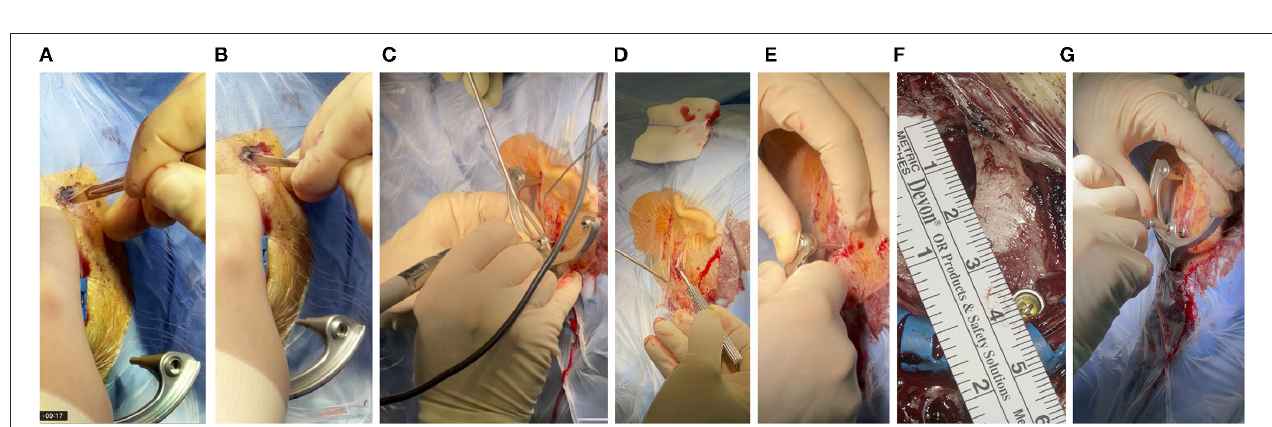
FIGURE 3 | (A) With a thin scalpel, the skin is punctured through the foil at the three marked spots for the pins of the frame, resulting in incision lengths of about 4-6 mm. (B) The periost is scraped so that the pin of the frame can be pressed directly onto the skull surface. (C) Pre-drilling and (D) fixation of the anchor, with a bone screw and (E) toque ratchet, (F) about 4 cm posterior to the EAC. (G) The same ratchet was used to attach the frame to the skull with the mounting screw, which in turn screws onto the